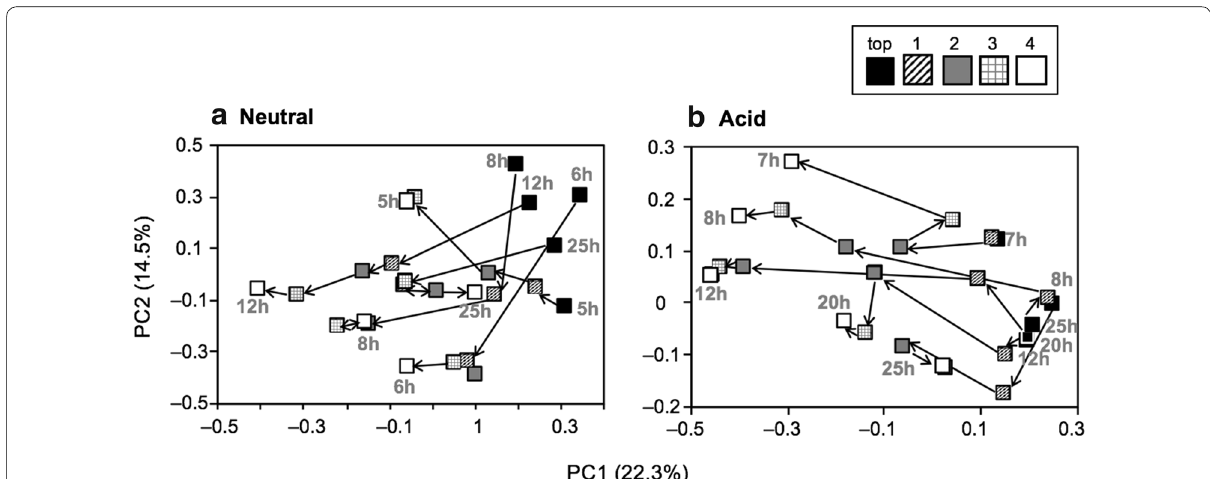
Fig. 3 Principal coordinate analysis (PCoA) scatter plot of 16S rRNA sequences based on the weighted UniFrac obtained by Illumina sequencing of the same number of sequences (40,525) of 25 samples from each depth of the bioreactor under the neutral ( a ) and acid ( b ) conditions. The depth of the bioreactor is as follows: top , closed squares ; port 1, hatched squares ; port 2, gray squares ; port 3, plaid squares ; port 4, open squares . Arrows indi- cate the direction from top to bottom of the bioreactor. The numbers beside the plots indicate their respective